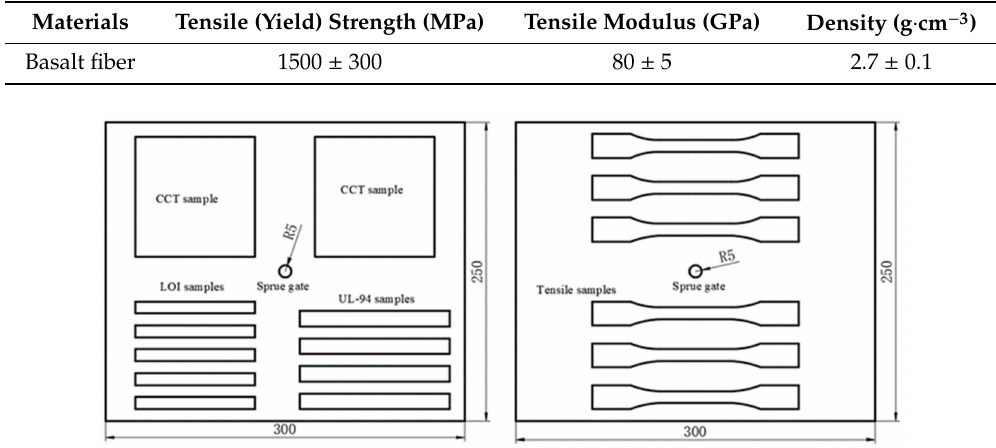
Figure 1. Samples location on the injection molded plates.